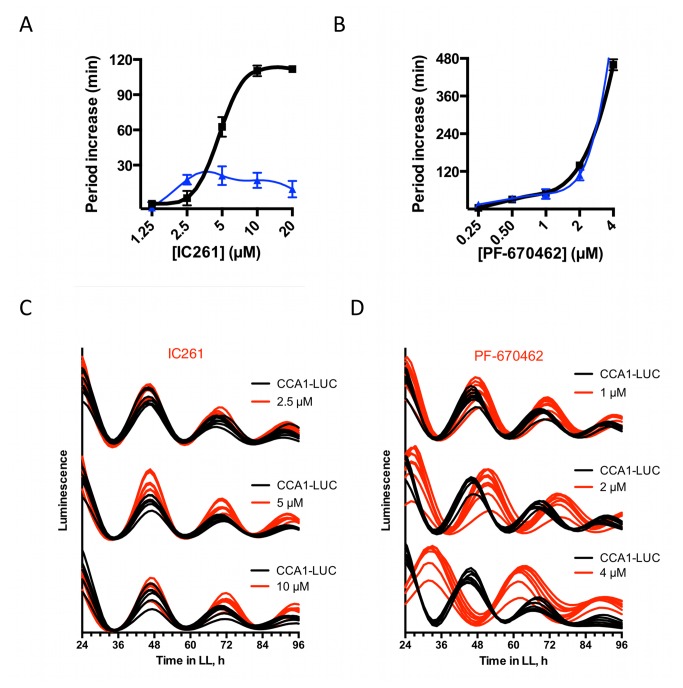
CK1 inhibitor leads to period lengthening.(A–B) Dose–response curves showing free-running period lengthening of CCA1-LUC lines (black line) treated with CK1 inhibitor IC261 (A) or PF-670462 (B). Blue line indicates the period effects of the same range of inhibitors on the CK1 overexpression line CK1-OX8. (C–D) For relevant drug concentrations, the raw data is provided for indicated inhibitor, compared to vehicle-treated CCA1-LUC parent cells (red traces are treated, black traces mock-treated, n=8).